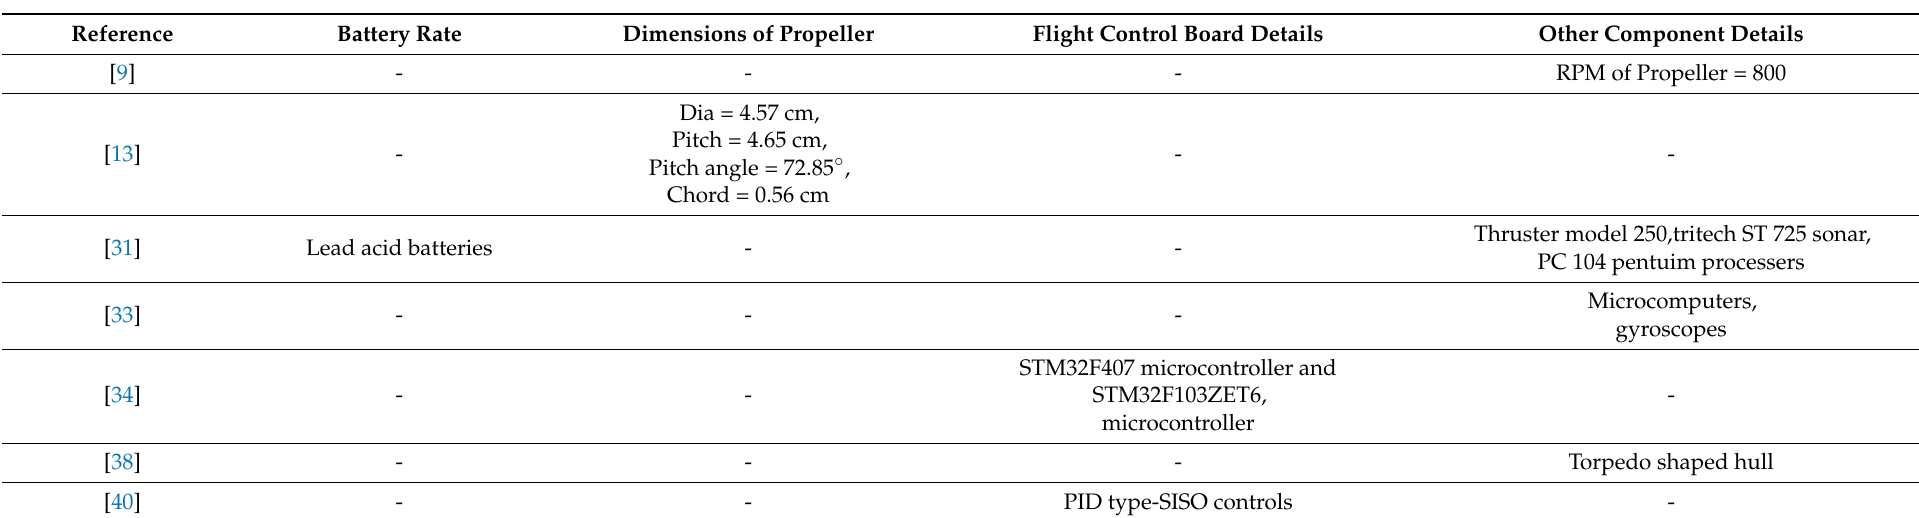
Table 4. Comparative information about components involved in unmanned underwater